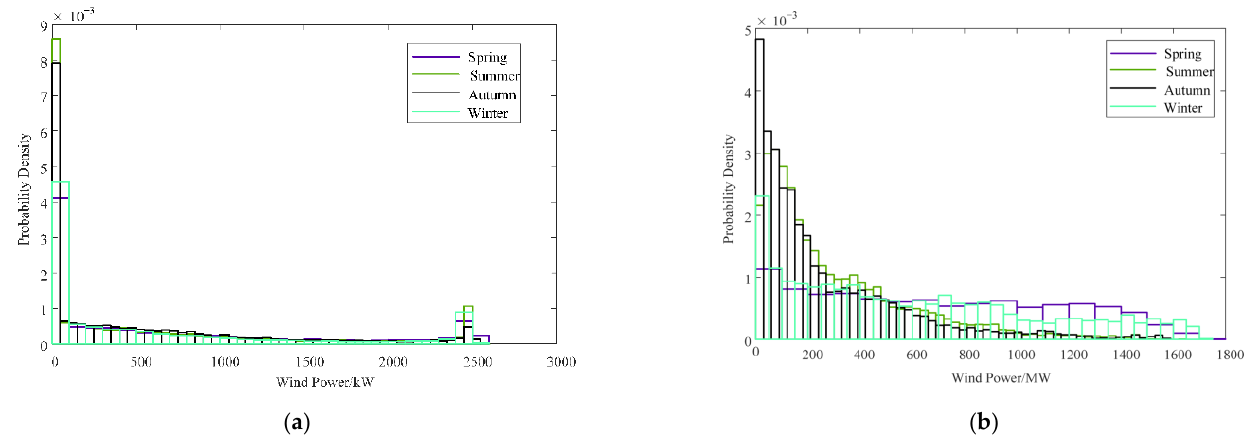
Figure 4. Probability density distributions of different seasons in different datasets: ( a ) Set 2; ( b ) Set 3.